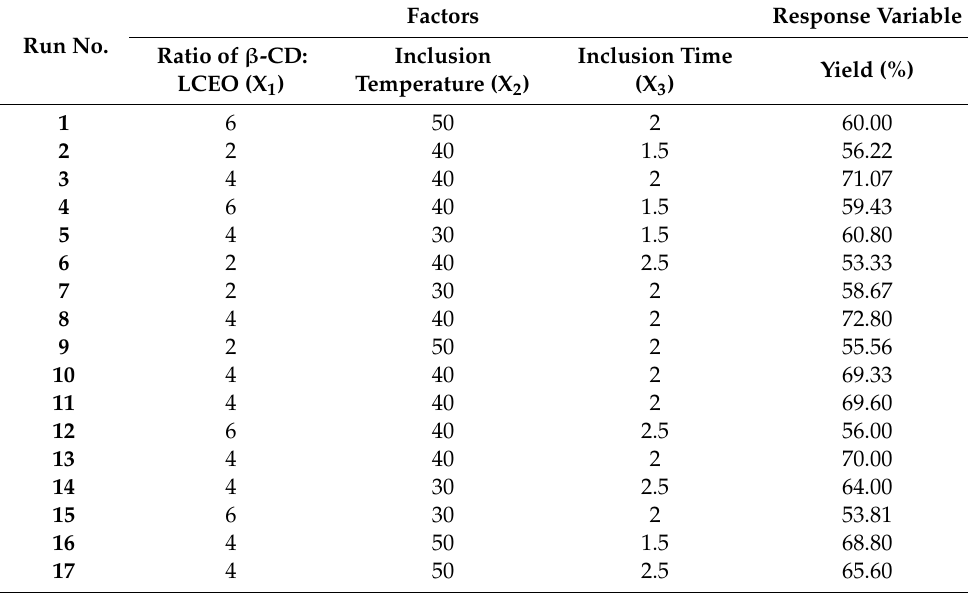
Table 2. Box–Behnken design with independent and response variables for preparation of LCEO / β -CD inclusion complex in di ff erent